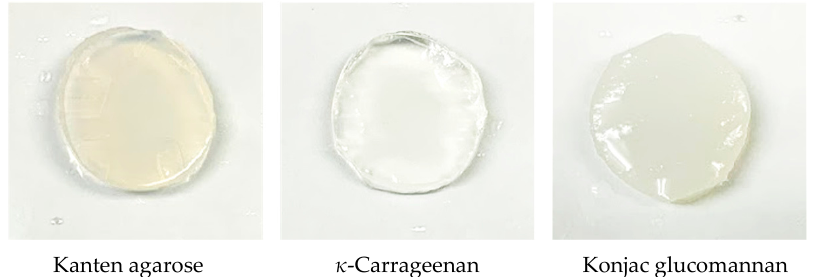
Figure 5. Pictures of biomass hydrogels of Kanten agar, κ -carrageenan, and konjac glucomannan.